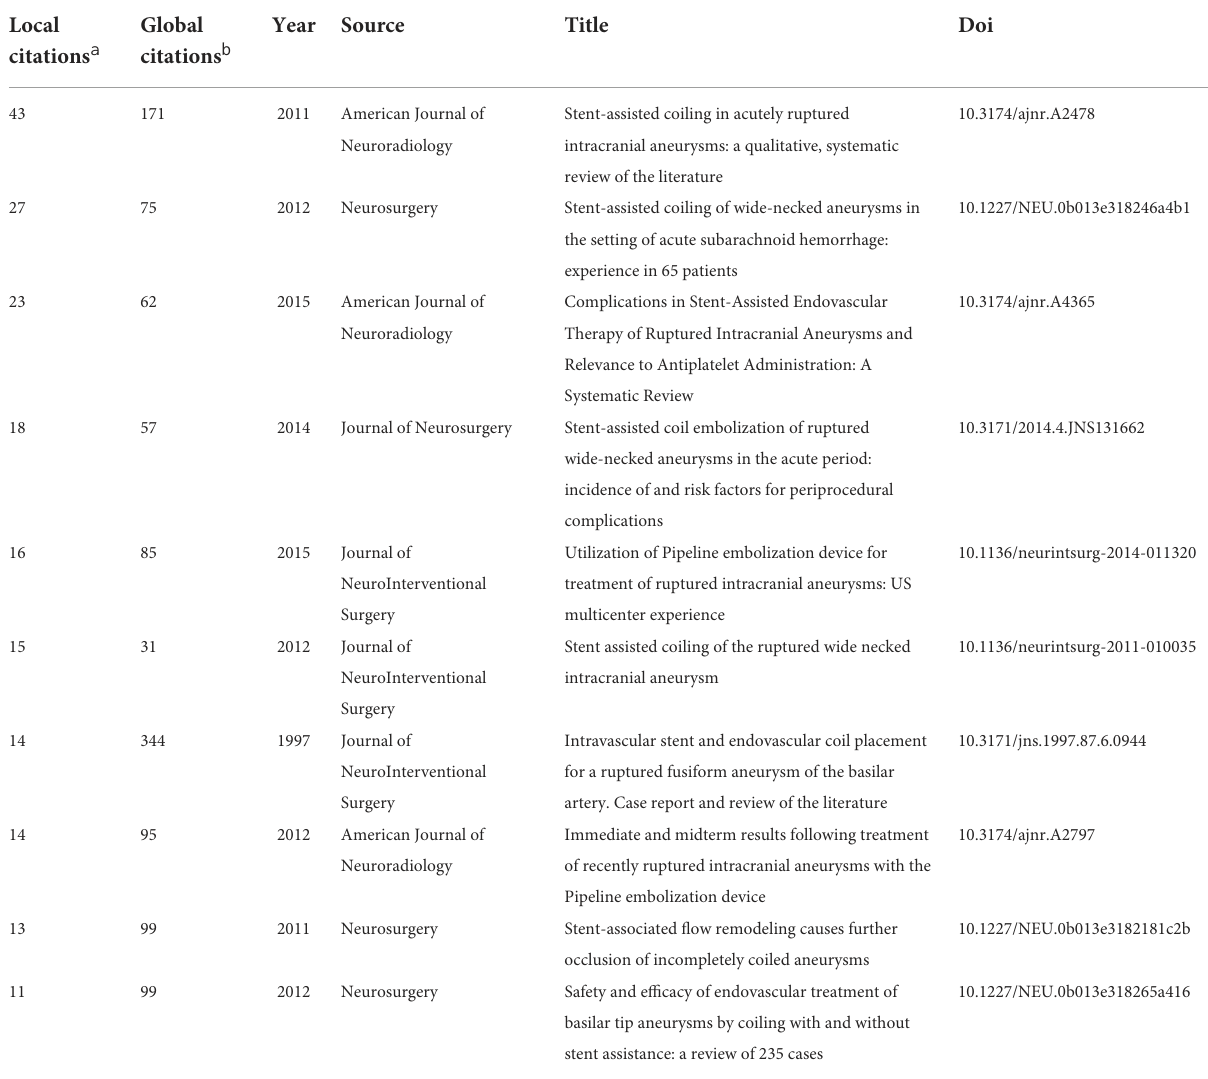
A country scientific production map was shown in Figure 4A and the cooperation networks across countries were mapped in Figure 4B. The US, as the landmark node, had extensive collaborations with other countries or regions